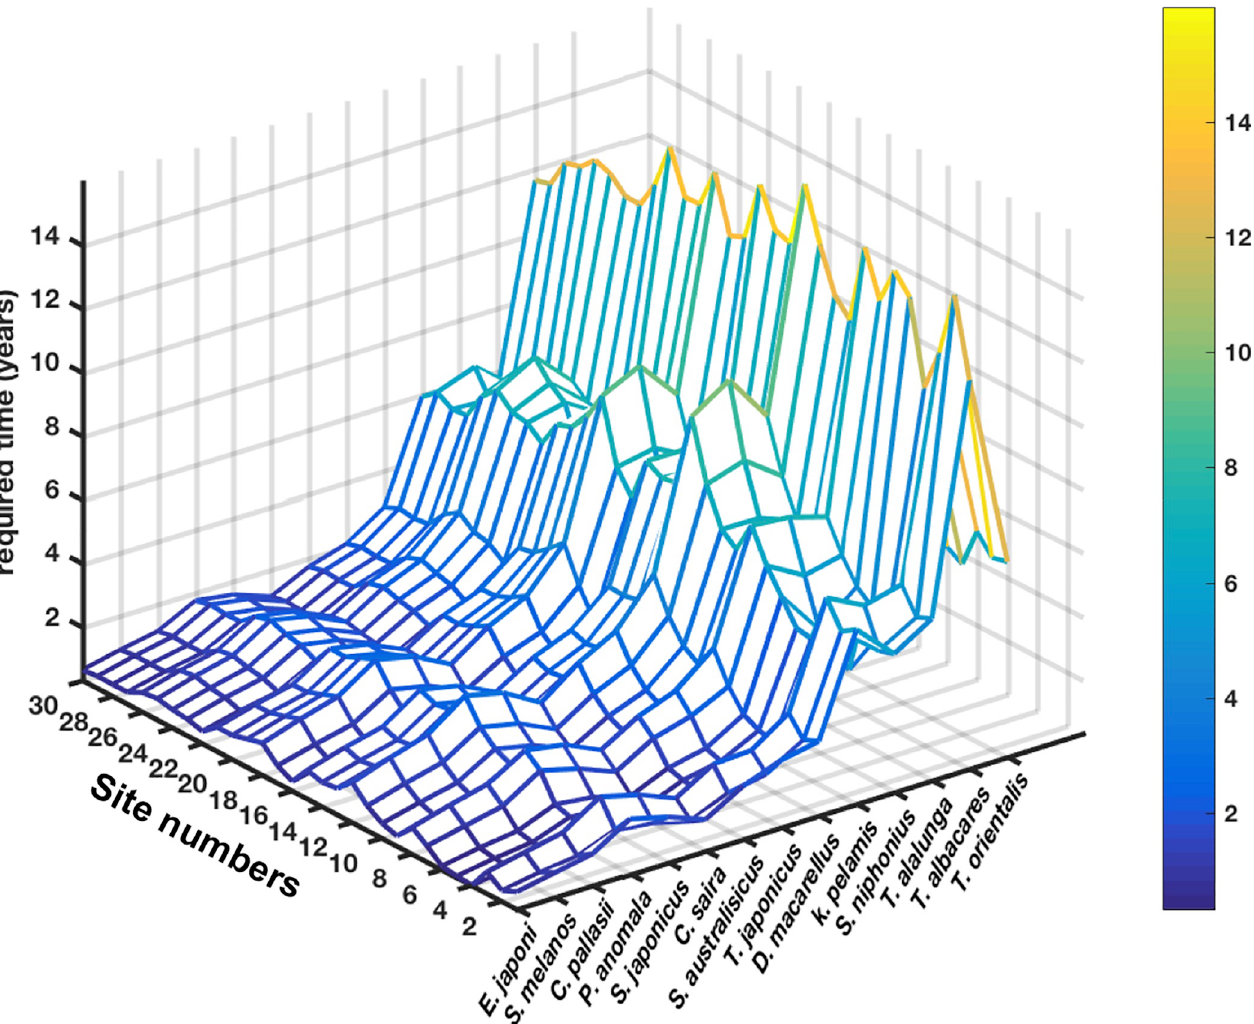
Fig 15. Estimated time duration (in years) required for the species to reach the pre-accident activity concentrations shown as function of studied species (x-axis) and sites (y-axis). The studied species are shown in an increasing order of their asymptotic